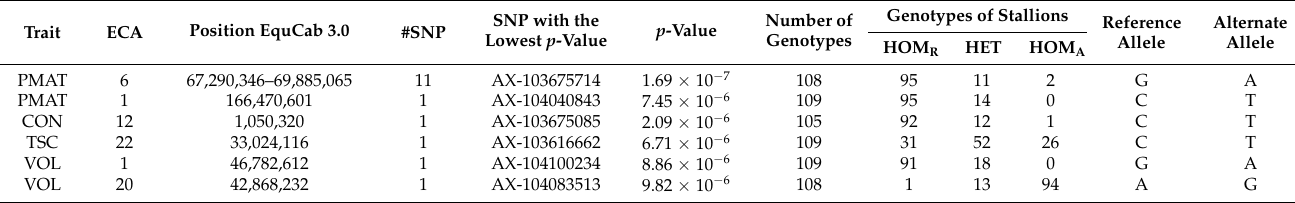
#SNP: the number of single nucleotide polymorphisms for a specific trait that passed the suggestive p-value threshold of 10 − 5 , P-value: p-value of the SNP with the lowest p-value per trait and locus corrected for genomic inflation (Pc1df from GenABEL), HOM R : homozygous for the reference allele, HET: heterozygous, HOM A : homozygous for the alternate allele, PMAT: progressive motility after thaw, CON: concentration, TSC: total sperm count, VOL: gel-free volum.